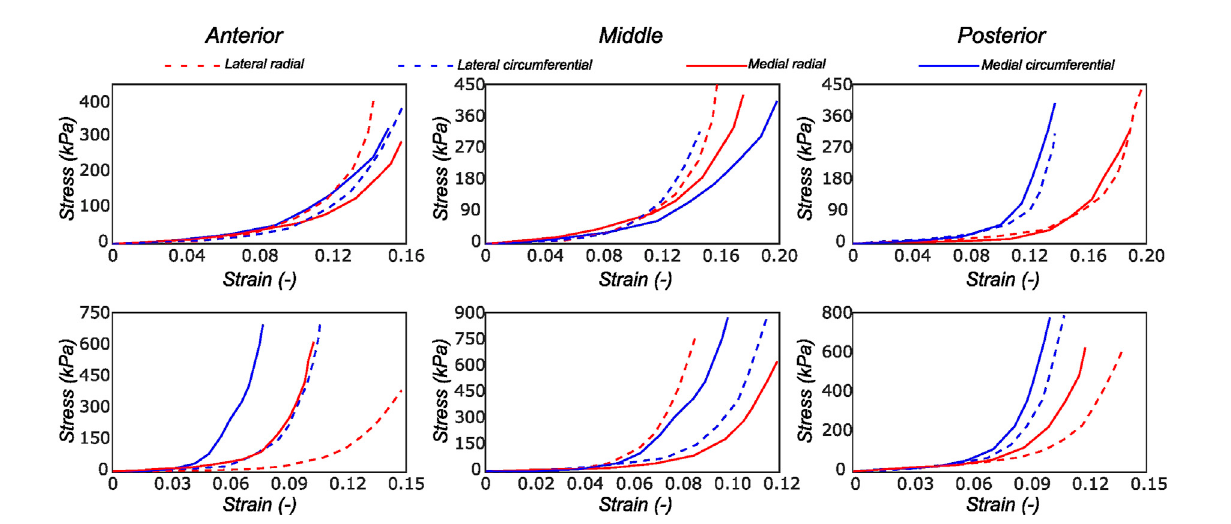
FIGURE 4 Computed Cauchy stress-strain curves for the meniscus samples (LM1 and MM1) obtained from the biaxial testing protocol. The top and bottom rows of subplots represent the samples from the top and bottom samples, respectively. Column-wise, they represent the anterior, mid-body, and posterior